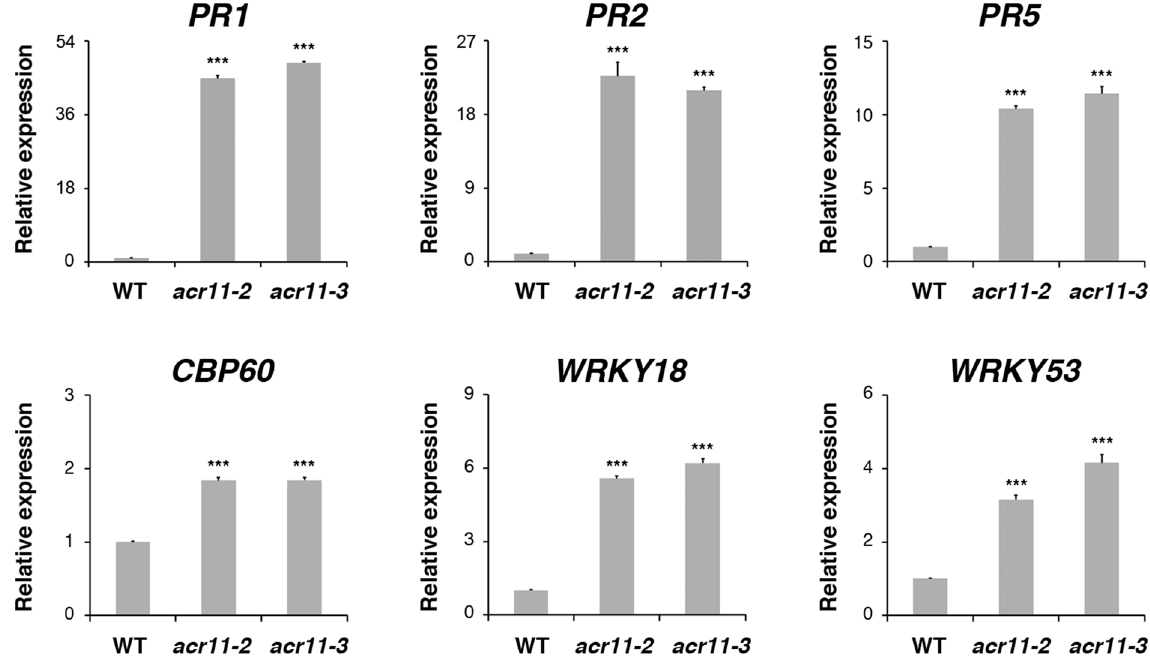
Figure 5. Quantitative RT-PCR analysis of salicylic acid-responsive genes. Total RNA extracted from rosette leaves of 5-week-old Arabidopsis wild-type (WT), acr11-2 , and acr11-3 mutant plants was used for qRT-PCR analysis to detect the expression of PR1 , PR2 , PR5 , CBP60G , WRKY18 and WRKY53 . Relative expression indicates the fold-change of each gene as compared to that of WT. Results shown are means ± SD from three independent experiments. *** P < 0.001 represents the result of Student’s t test.